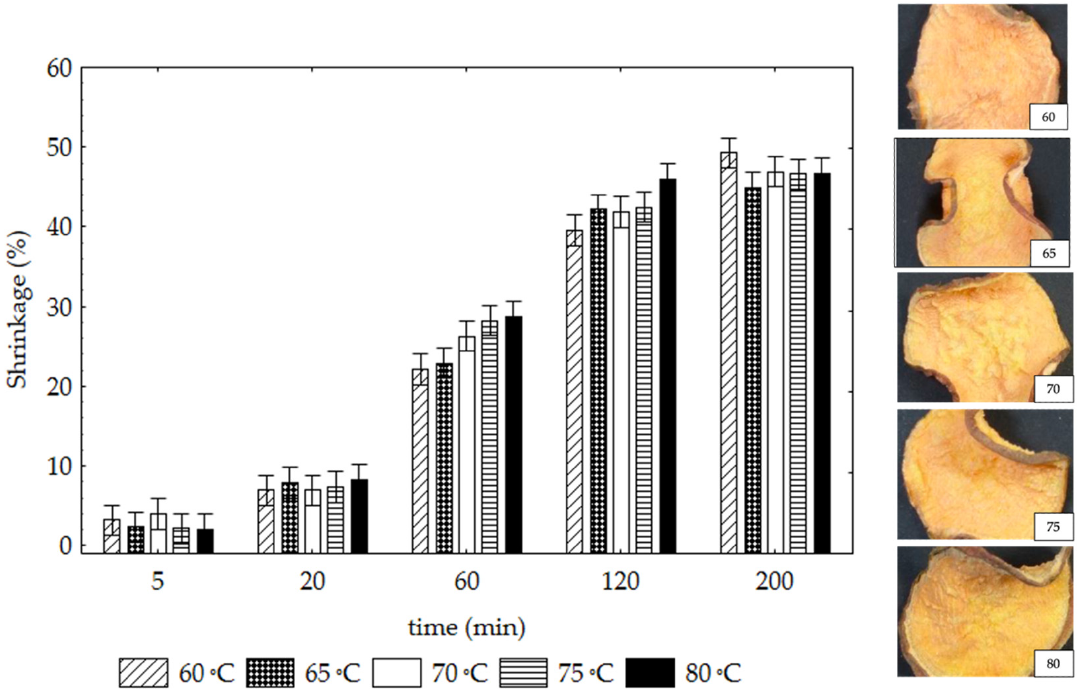
Figure 2. Drying process effect on shrinkage values (%) of SP samples at different temperature-time conditions and photos of the dehydrated product at the end of 200 min. Vertical bars denote 0.95 confidence intervals.